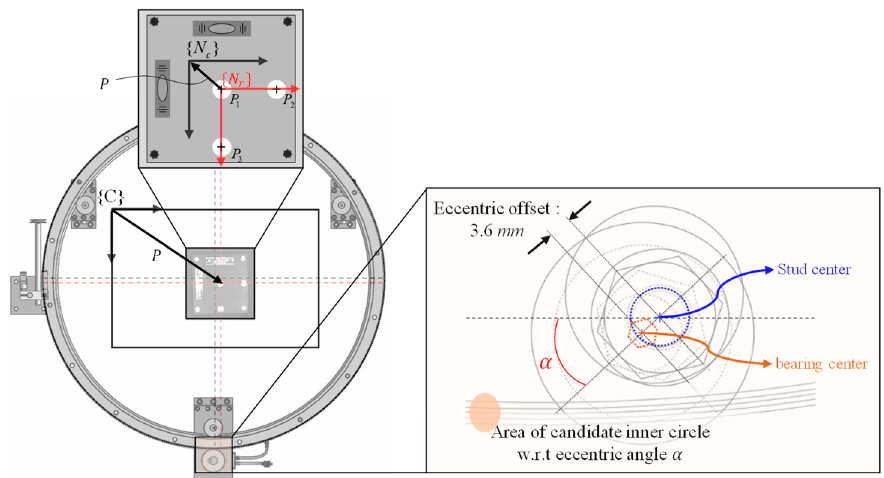
Figure 15. Range of the center point of the CMS with the variation of the eccentric angle.